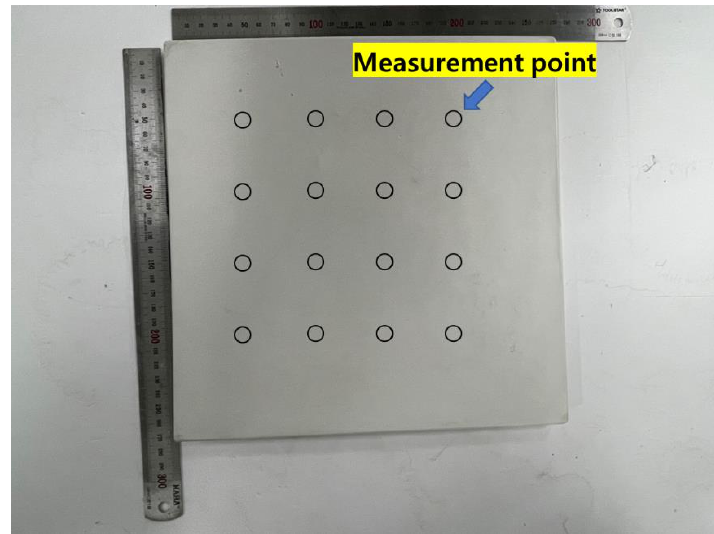
Figure 7. Chromaticity analysis points marked on a specimen. Table 3. Color-difference analysis results of